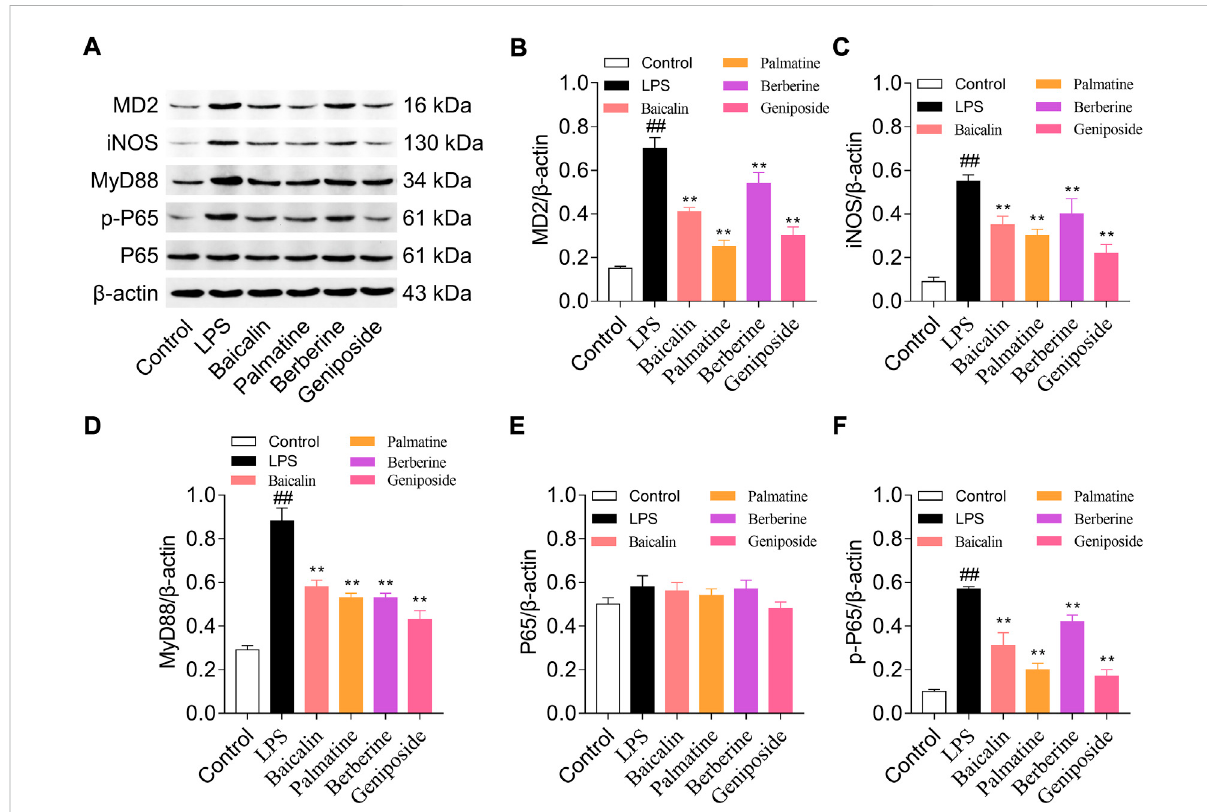
FIGURE 3 MD-2, MYD88, p65, p-p65, and iNOS proteinexpression levels in RAW 264.7 cells treated with baicalin, palmatine, berberine, orgeniposide. (A) Westernblotelectrophoresisresults, (B) relativeproteinexpressionofMD-2, (C) relativeproteinexpressionofiNOS, (D) relativeproteinexpressionof MYD88, (E) relative protein expression of p65, and (F) relative protein expression of